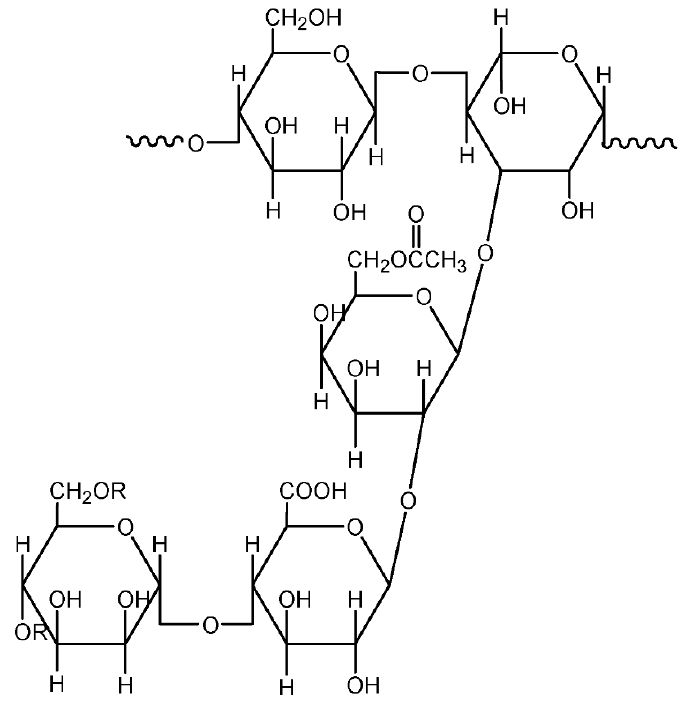
Figure 16. Representative unit of xanthan gum.